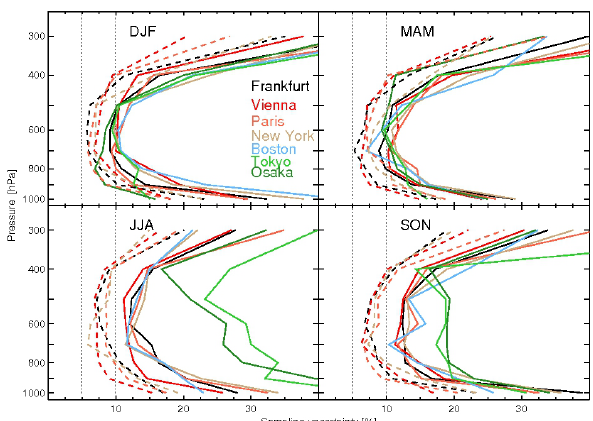
Fig. 7. Vertical profiles of the climatological sampling uncertainty in percentages (2 . 6 · s samp , N f ) for the seven northern mid-latitude seas , clim sites, color-coded by cities. The sampling uncertainty at the fre- quency N f = 4 (12) is shown in solid (dashed) lines. As stated in the text, only Frankfurt, Vienna, Paris and New York are shown for the frequency N f = 12. The vertical dotted lines are the 5 and 10% value lines, uncertainty values commonly quoted for measurement error of ozone